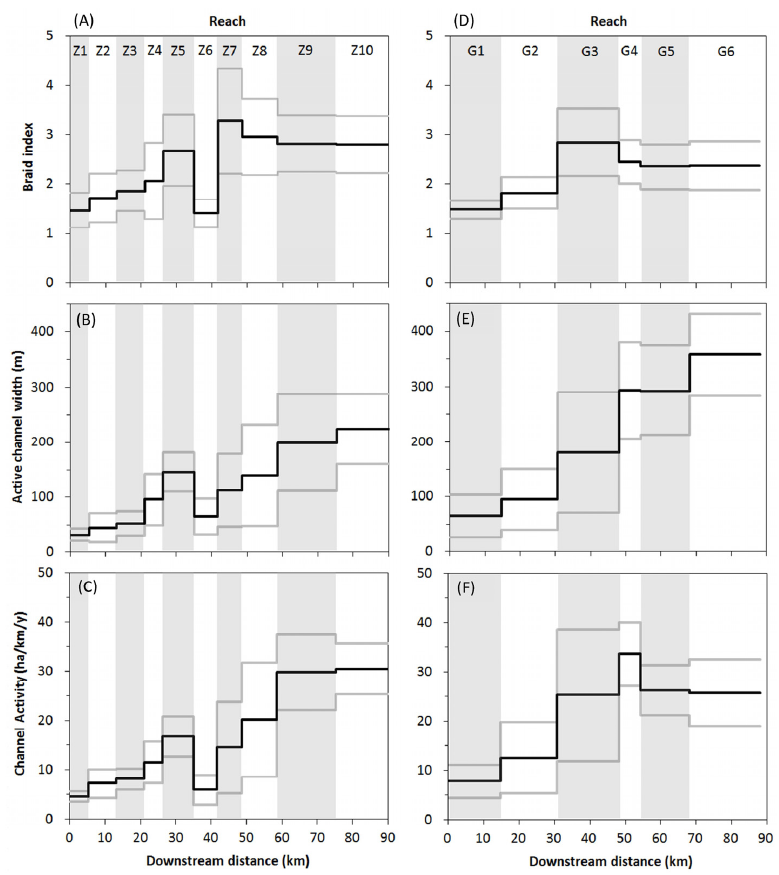
Figure 4. Downstream patterns of braid index, active channel width, and channel activity along the Zhuoshui River ( A – C ); and the Gaoping River ( D – F ) during 2008–2015. Black lines show the average values and grey lines show the ranges of ±1 standard deviation.